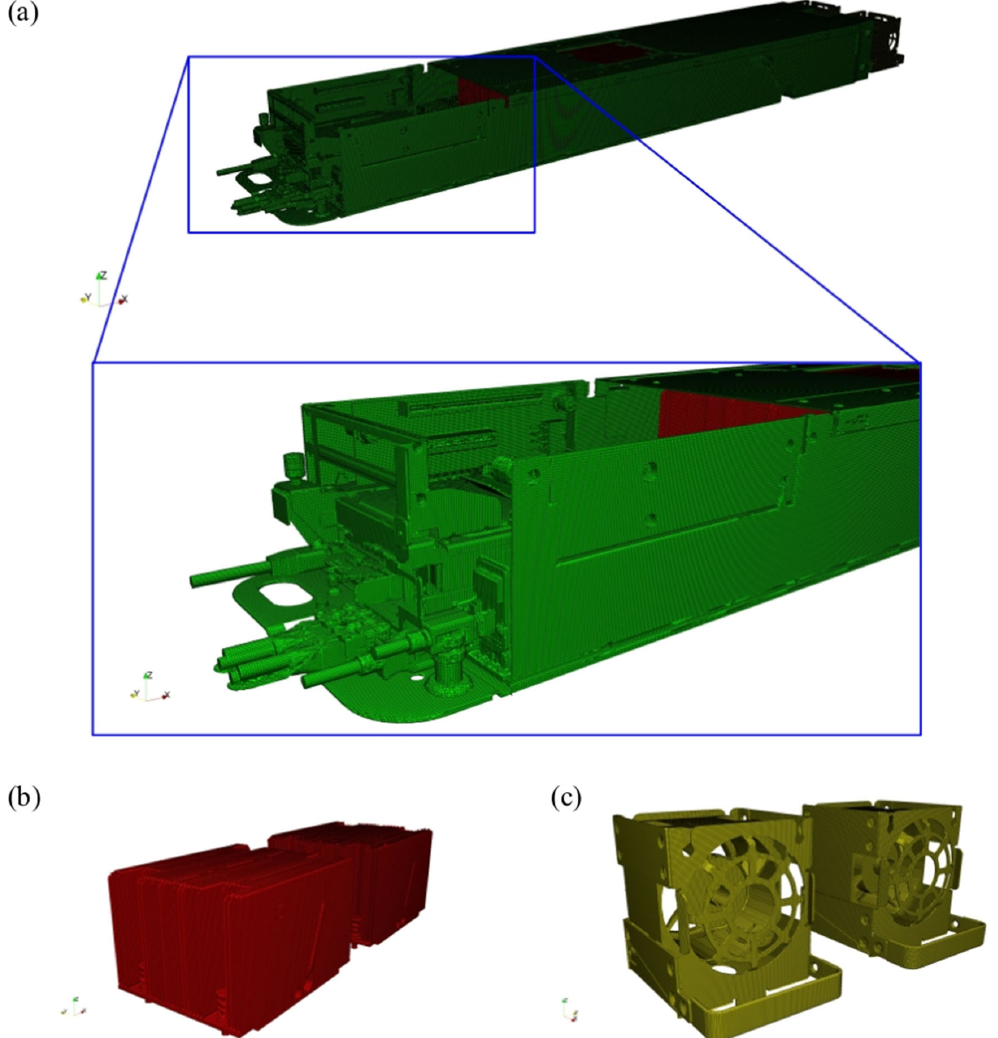
Table 2. Mesh statistics for the complete model.